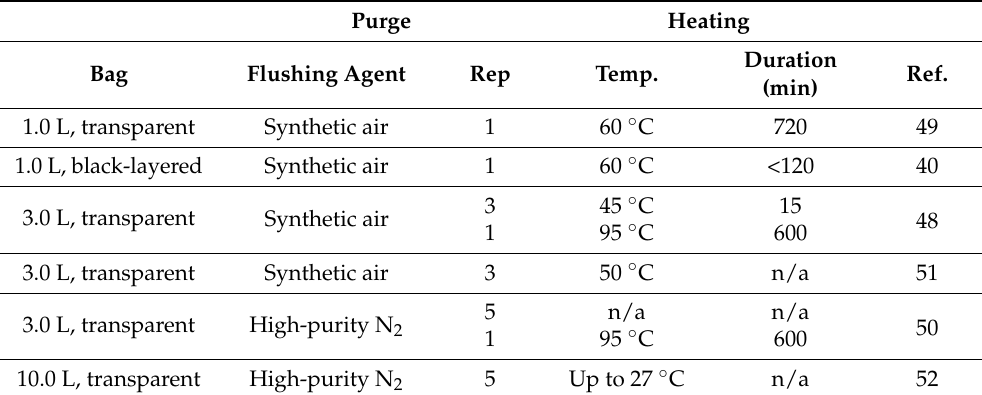
Table 1. Tedlar bag’s cleaning